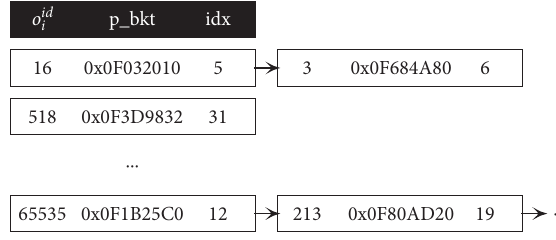
Figure 1: An example of the auxiliary index.